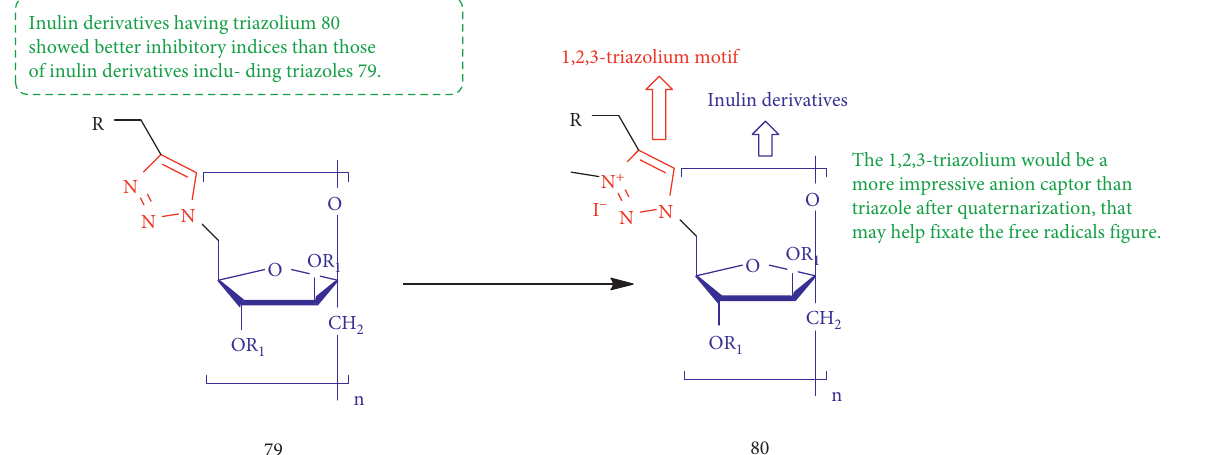
Figure 31: Chemical structure of inulin derivatives possessing 1,2,3-triazolium charged units.